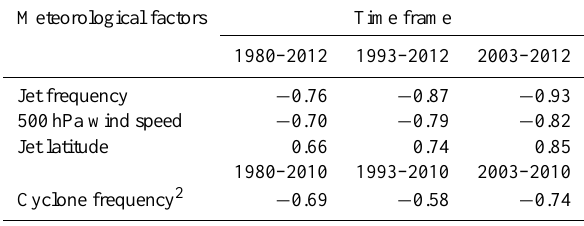
Table 1. The correlation coefficients r of regionally detrended 1 mean JJA MDA8 ozone concentration and different meteorologi- cal factors in the Midwest and northeast over different time periods. See text for definitions of these factors. All correlations are statisti- cally significant at the 0.05 level.